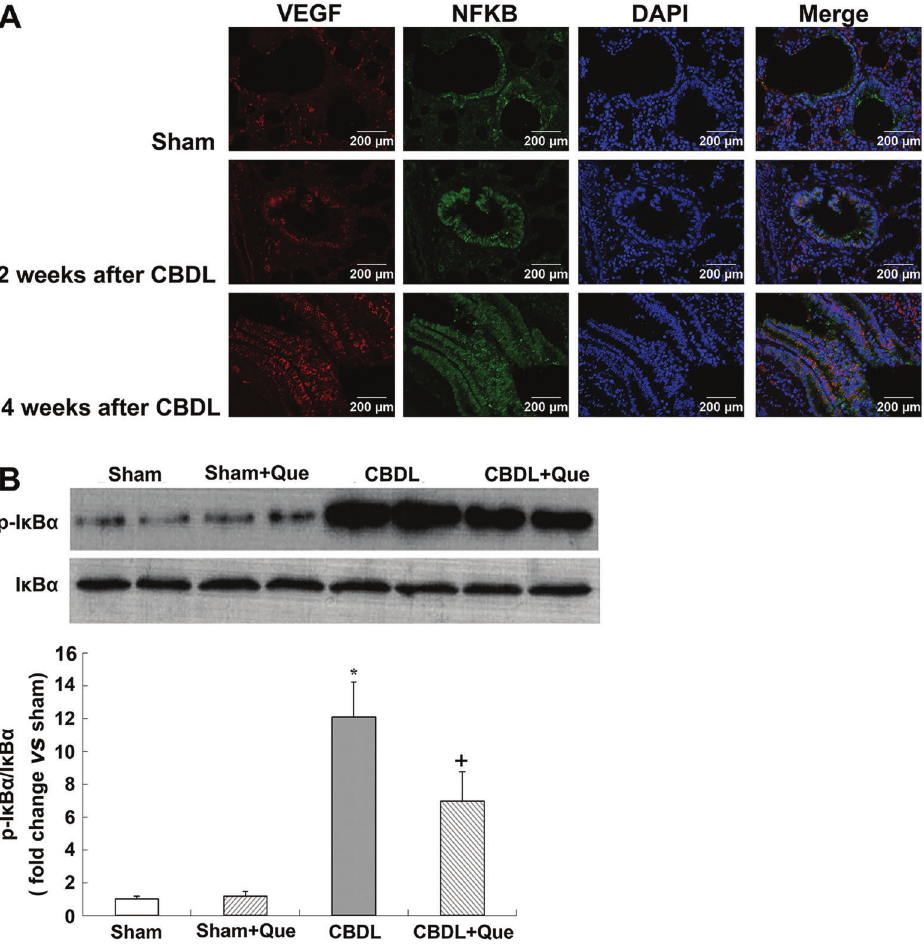
Figure 5. Immuno fl uorescence localization of NF- k B p-65 and VEGF-A after common bile duct ligation (CBDL). Effects of quercetin (Que) on the level of lung I k B a phosphorylation after CBDL. A , Representative double-labeling images of p-65 and VEGF-A (original magni fi cation, 40 (cid:3) ). B , Representative immunoblots and graphical summaries of lung p-I k B a /I k B a . Sham (sham-operated), n=8; CBDL, n=6; Que (sham + quercetin), n=8; CBDL + Que, n=8. Data are reported as the mean ± SD. *P o 0.05 compared with sham rats. + P o 0.05 compared with CBDL rats